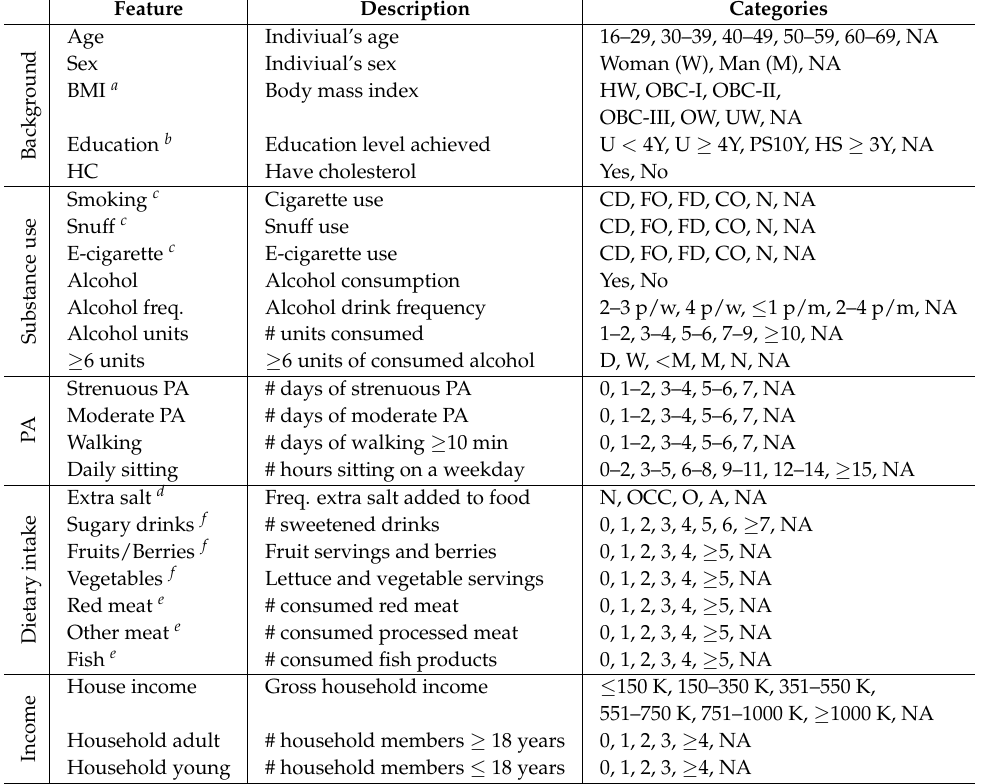
Table 1. Summary of the features and categories in the